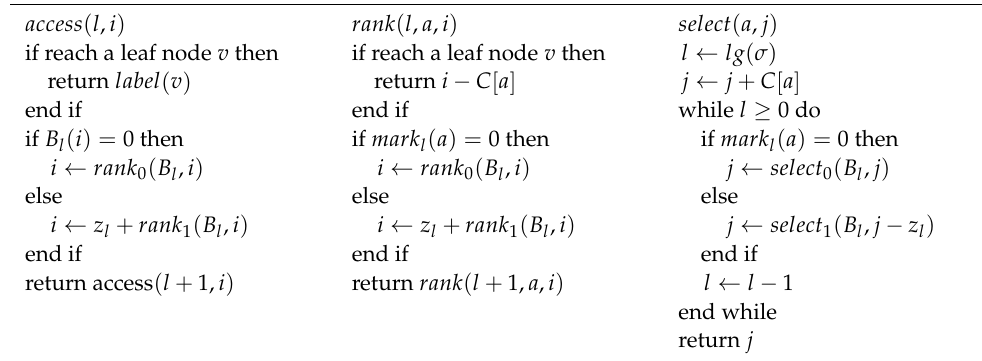
Algorithm 1 Wavelet matrix algorithms: on the wavelet matrix of sequence S , access ( 0, i ) returns